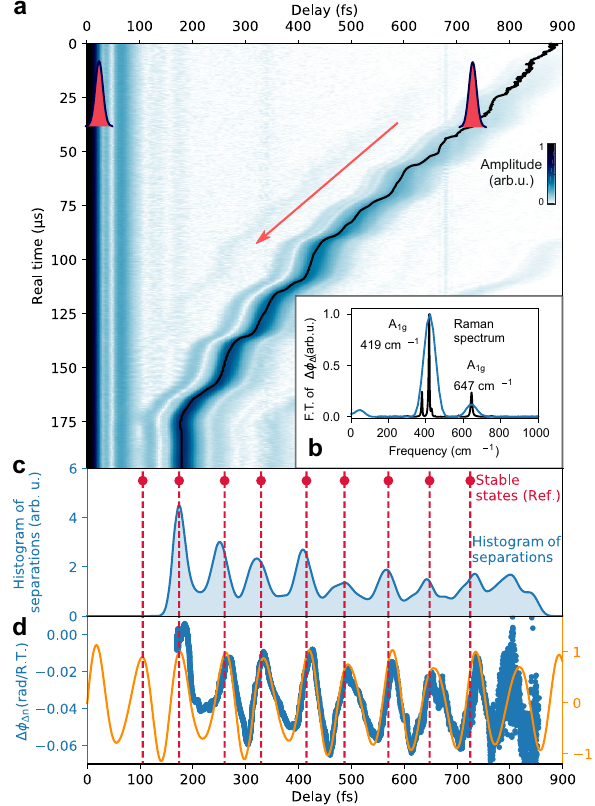
Fig. 2 Transient approach of two solitons and extraction of the temporal Raman response. a The evolution of soliton separations is obtained via Fourier amplitudes of roundtrip-resolved interferograms, presenting fi eld- autocorrelations. The side peaks represent the separation and are highlighted (black line). Experimental data from Ref. 10 . b The resulting Fig. 3a: Two initially separated solitons (red) experience different Raman spectrum obtained from Fourier transformation of the measured laser gain due to transient gain depletion (blue). Whereas closely phase signal Δ ϕ Δ τ ð Þ (see d ) and a reference spectrum from the Raman spaced pulses in modelocked lasers without Kerr-lensing typically database 26 . c The histogram of transient separations, derived as the sum of separate further apart due to the dominant role of the gain all autocorrelations, reveals the separations of meta-stable bound-states. gradient 18,28 , here, the high Kerr nonlinearity is accompanied by The latter coincide with stable bound-states observed by Kitano et al. in signi fi cant self-steepening. In line with experimental observations, Ref. 8 , marked by red dots and dashed lines. d The relative phase-change the resultant intensity-dependent group velocity difference Δ v τ ð Þ , extracted via consecutive double-referencing, yields per roundtrip, Δ ϕ Δ slows the fi rst soliton and induces approaching relative motion. n the temporal Raman waveform. For comparison, the theoretical Raman response is included in orange, and evidences that bound-states form at local maxima, i.e., phonon